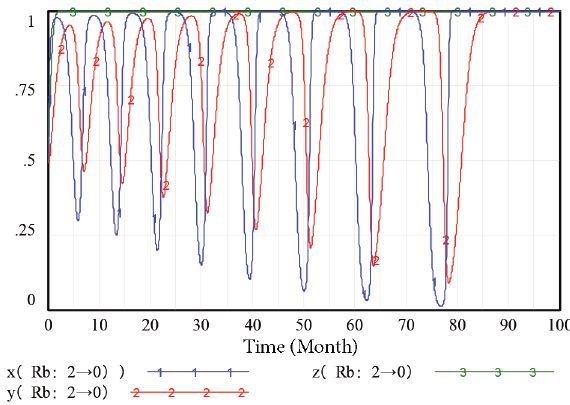
Figure 9. Game results under reward change for CC ( R b )